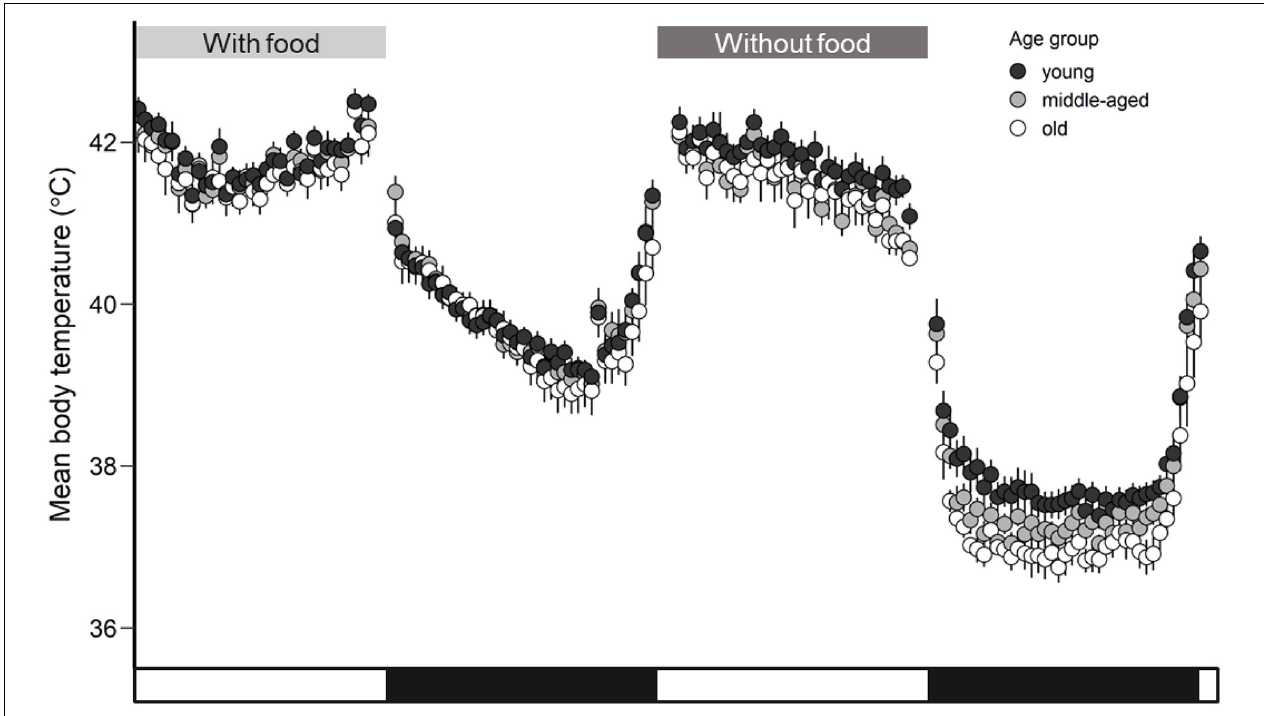
FIGURE 1 | Mean body temperature ( ◦ C) calculated for each age group (young, middle-aged, old) of zebra finches with access to food and rest-phase hypothermia in response to a day without access to food. Whiskers represent standard errors. Black points represent the young group, light gray the middle-aged and white the old group of birds. The white and black bars in the x -axis correspond to the light and dark phase. TABLE 1 | Results of analysis of covariance (ANCOVA) of T bmean , T bmin , T bmax , and T bmedian ( ◦ C) in response to food deprivation conditions separately for day and night. Variable Young Middle-aged Old Age factor Body mass LSM SE LSM SE LSM